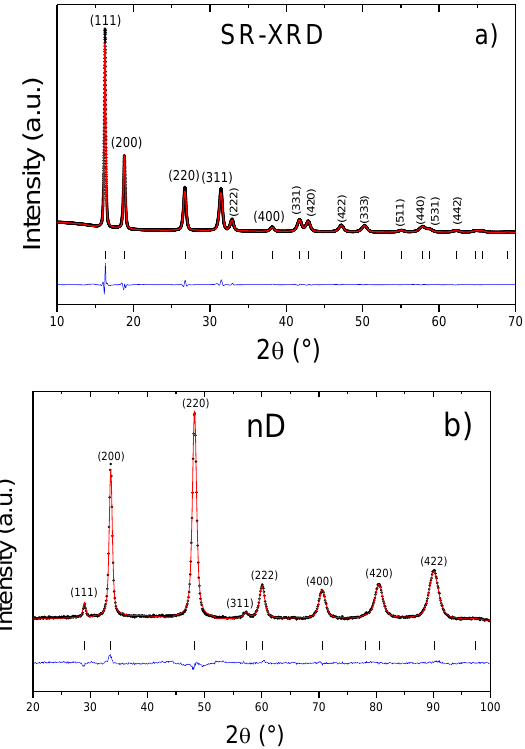
Figure 4. ( a ) SR-XRD pattern (λ = 0.7289 Å) with the corresponding Rietveld analysis of the hydride